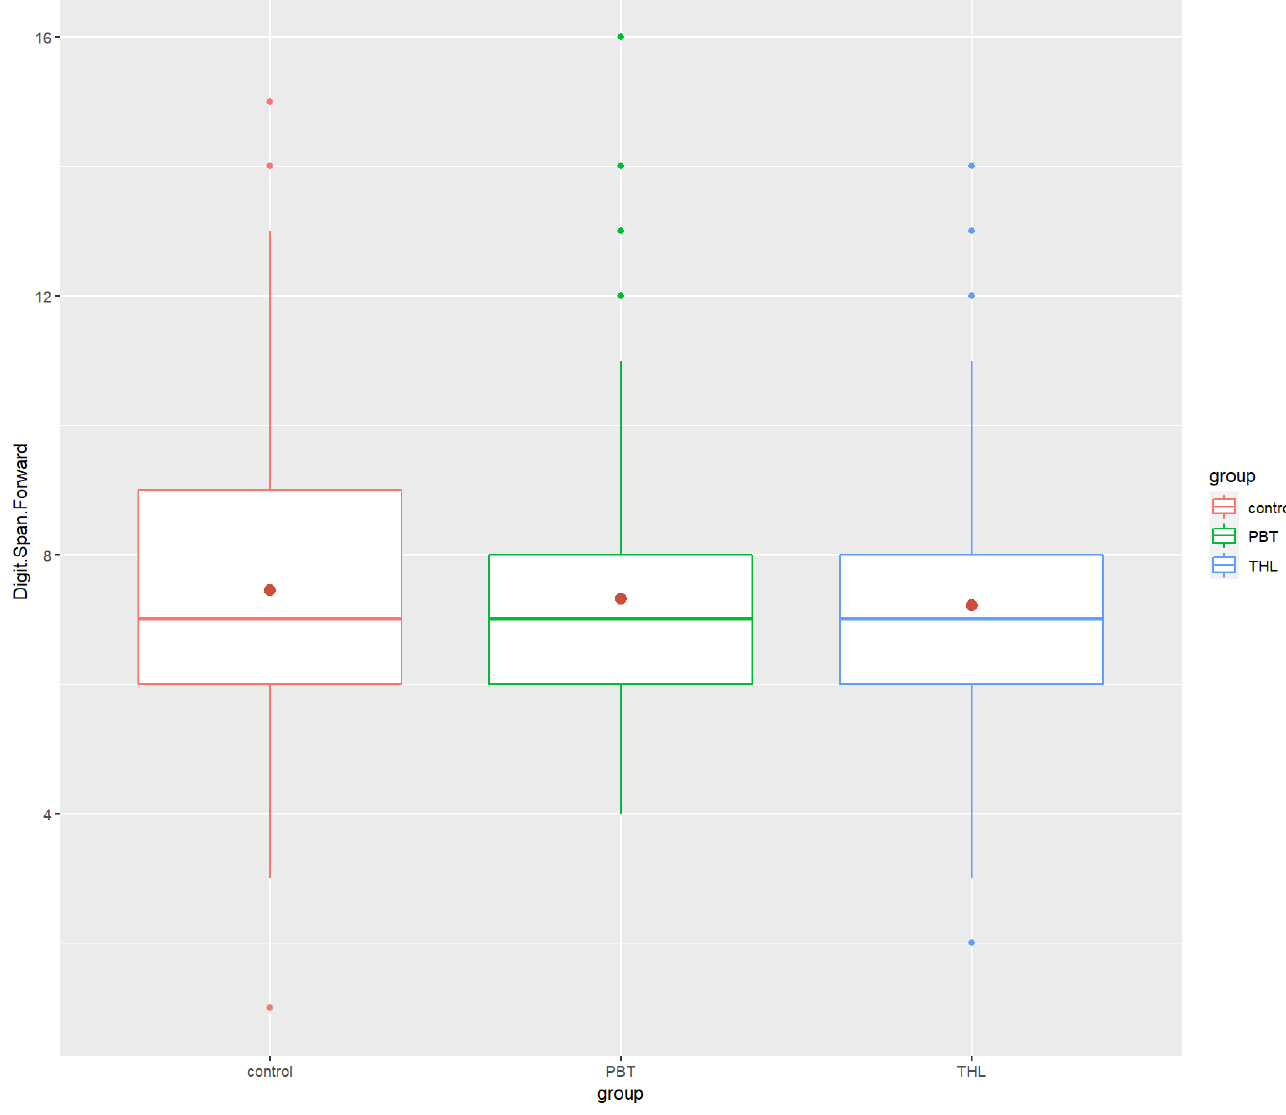
Figure 1. Boxplots of Digit Span Forward for the healthy control group and the diagnosis groups. Control — healthy control group, PBT — pediatric brain tumor survivors, THL — hematopoietic and lymphoid tissues tumor survivors. Red dot — mean test score for each group.